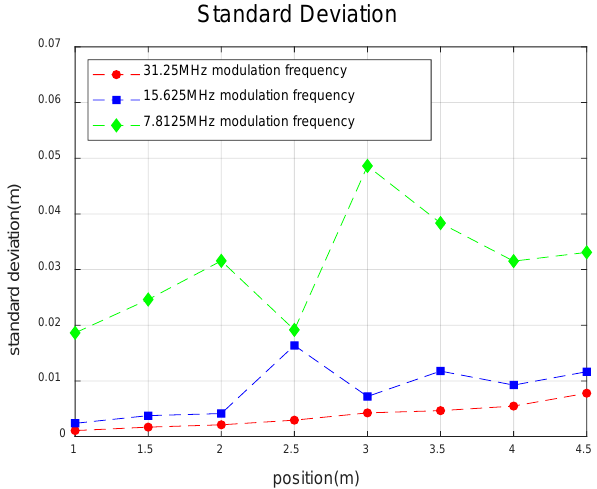
Figure 7. Standard deviation per modulation frequency.